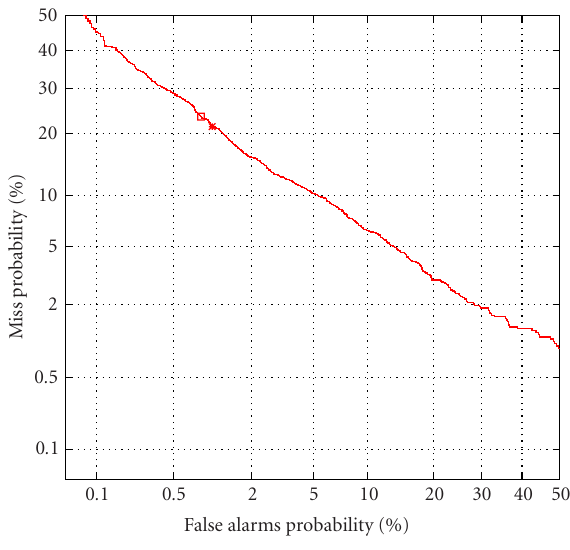
Figure 6: Example of a DET